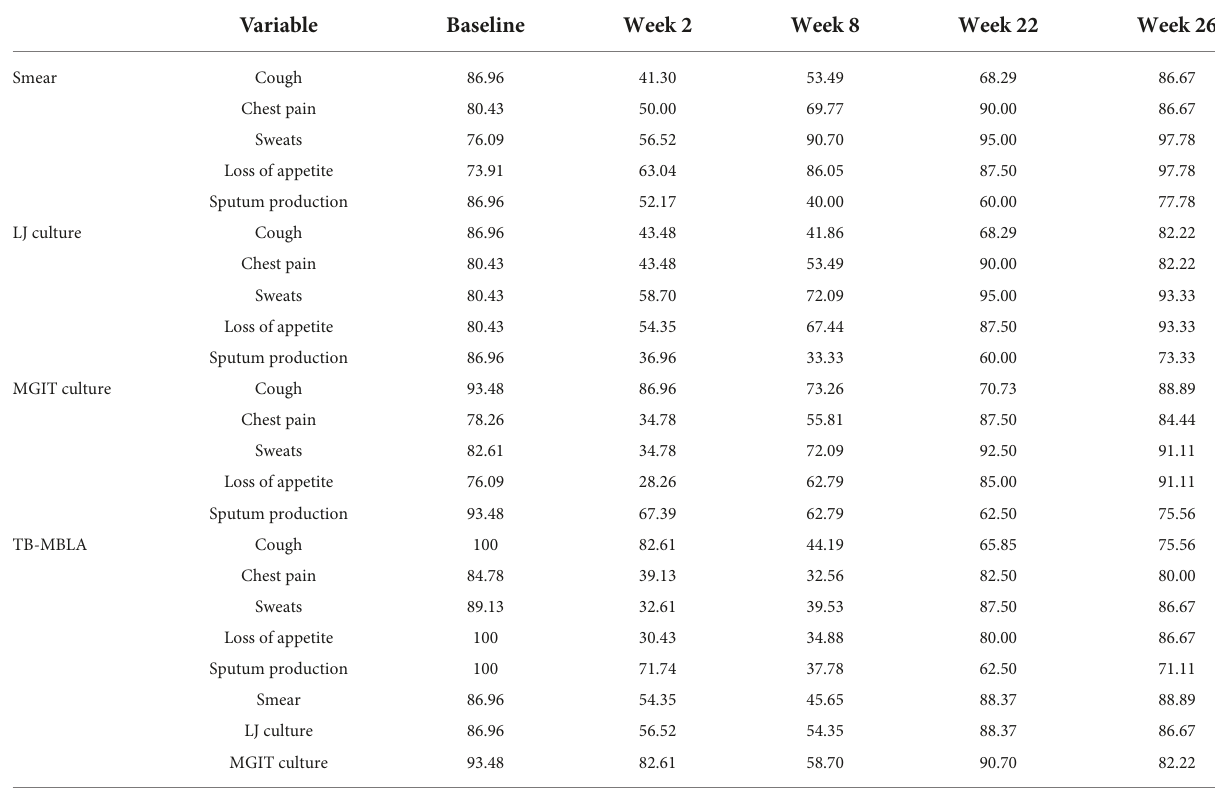
TABLE 2 Percentage (%) agreement of clinical symptoms with bacteriological tests.